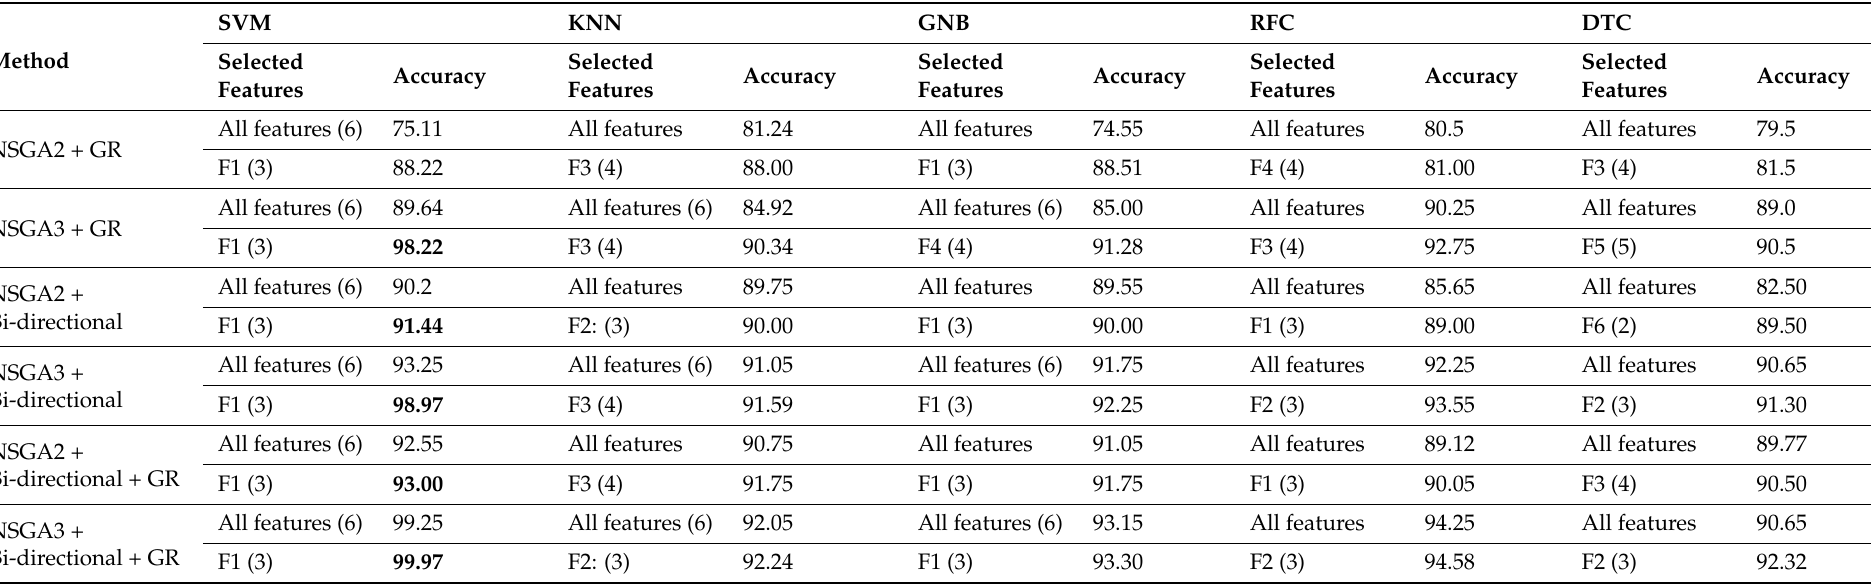
Table 2. Results of the independent runs of the algorithms for IoV vehicle collision feature selection and